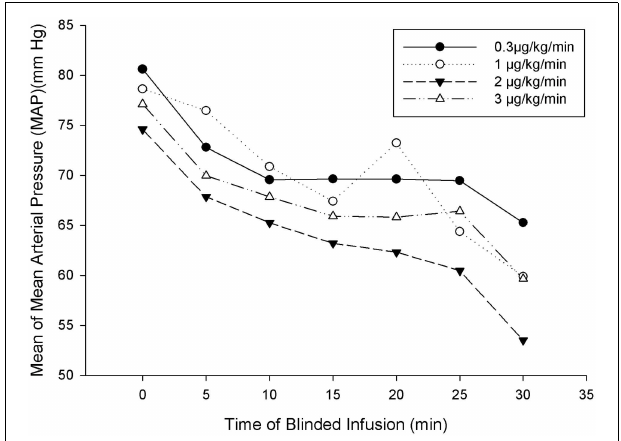
FIGURE 2 | Mean MAP over time for ITT patients for the 30-min blinded